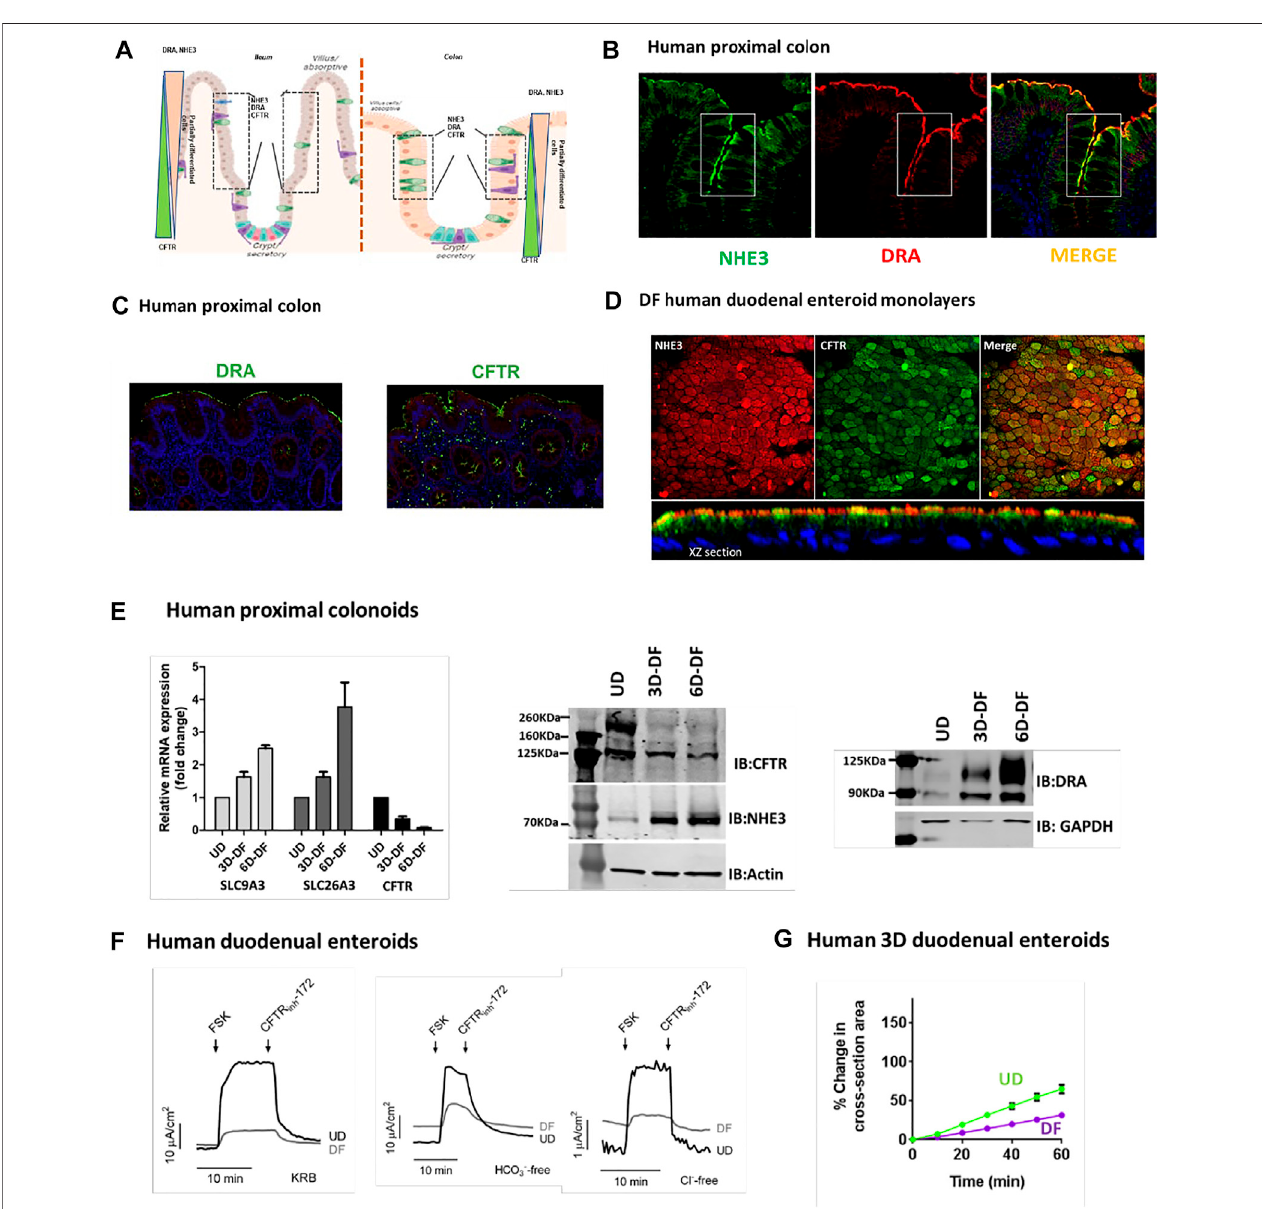
FIGURE 1 | (A) . Cartoon showing localization of ileal and colonic enterocytes expressing NHE3, DRA, and CFTR in the same cell. The boxed area shows the cell populationinwhichNHE3,DRA,andCFTRoccurinthesamecells. (B) .Immuno fl uorescenceofthehumanproximalcolonshowstheoverlapinthedistributionofNHE3and DRA [from Atlas of Intestinal Transport (Tuner, 2020)]. (C) . Representative immuno fl uorescence of the human proximal colon showing localization of DRA and CFTR in the same cellpopulations [from (Tse et al., 2019)]. (D) . Immuno fl uorescence of differentiated normal human duodenal enteroids (XY sections, above; XZ sections, below), demonstrating bothNHE3and CFTRinthe samecells.NHE3(red) isprimarilyinthe BB,while CFTRisexpressed insomecells inthe BBand insome cells subapically. (E). Expression (mRNA, left; protein, middle and right) of NHE3, DRA, and CFTR in human proximal colonic enteroids comparing growth in an undifferentiated state (grown in Wnt3A, R-spondin, and noggin) and when differentiated by removal of Wnt3A and R-spondin for 3 days ( “ partially differentiated ” ) or 6 days ( “ differentiated ” ). (F) . CFTR- dependentactiveanionsecretionispresentinbothundifferentiatedanddifferentiatednormalhumanduodenalenteroidmonolayers.Short-circuitcurrentofvoltage-clamped duodenal enteroid monolayers is shown in response to forskolin (10 µM). Active anion secretion occurs in both the undifferentiated and differentiated enteroids (undifferentiated > differentiated), and the secretion occurs both in the absence of Cl − or HCO 3 − in the bathing solutions. All the demonstrated anion secretion is CFTR- dependent on being inhibited by CFTR inhibitor -172 [from (Yin et al., 2018), Figures 7A – C ]. (G) . Forskolin-induced swelling assay in normal human 3D duodenal enteroids occurred in both differentiated and undifferentiated states (undifferentiated > differentiated) [from (Yin et al., 2018), Figure 5J ].